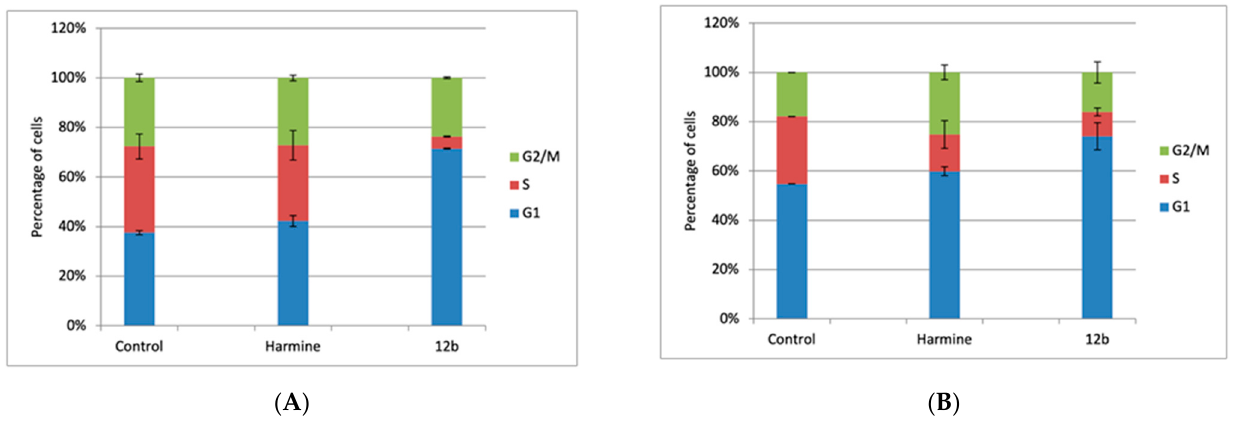
Figure 4. The effect of 12b and harmine on the cell cycle distribution of MCF-7 cells. Cells were treated with 10 µM of 12b and 20 µM of harmine for 24 h ( A ) and 48 h ( B ), and then the cell cycle was analyzed by flow cytometry. The histograms represent the percentage of cells in the respective cell cycle phase (G1, S, and G2/M). Average values from three individual experiments ± SD are presented.